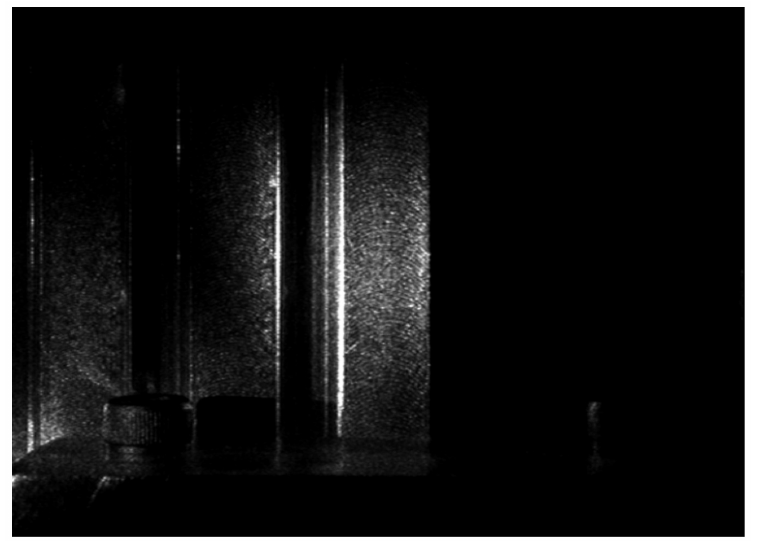
Figure 3. Laser speckle pattern from experimental setup